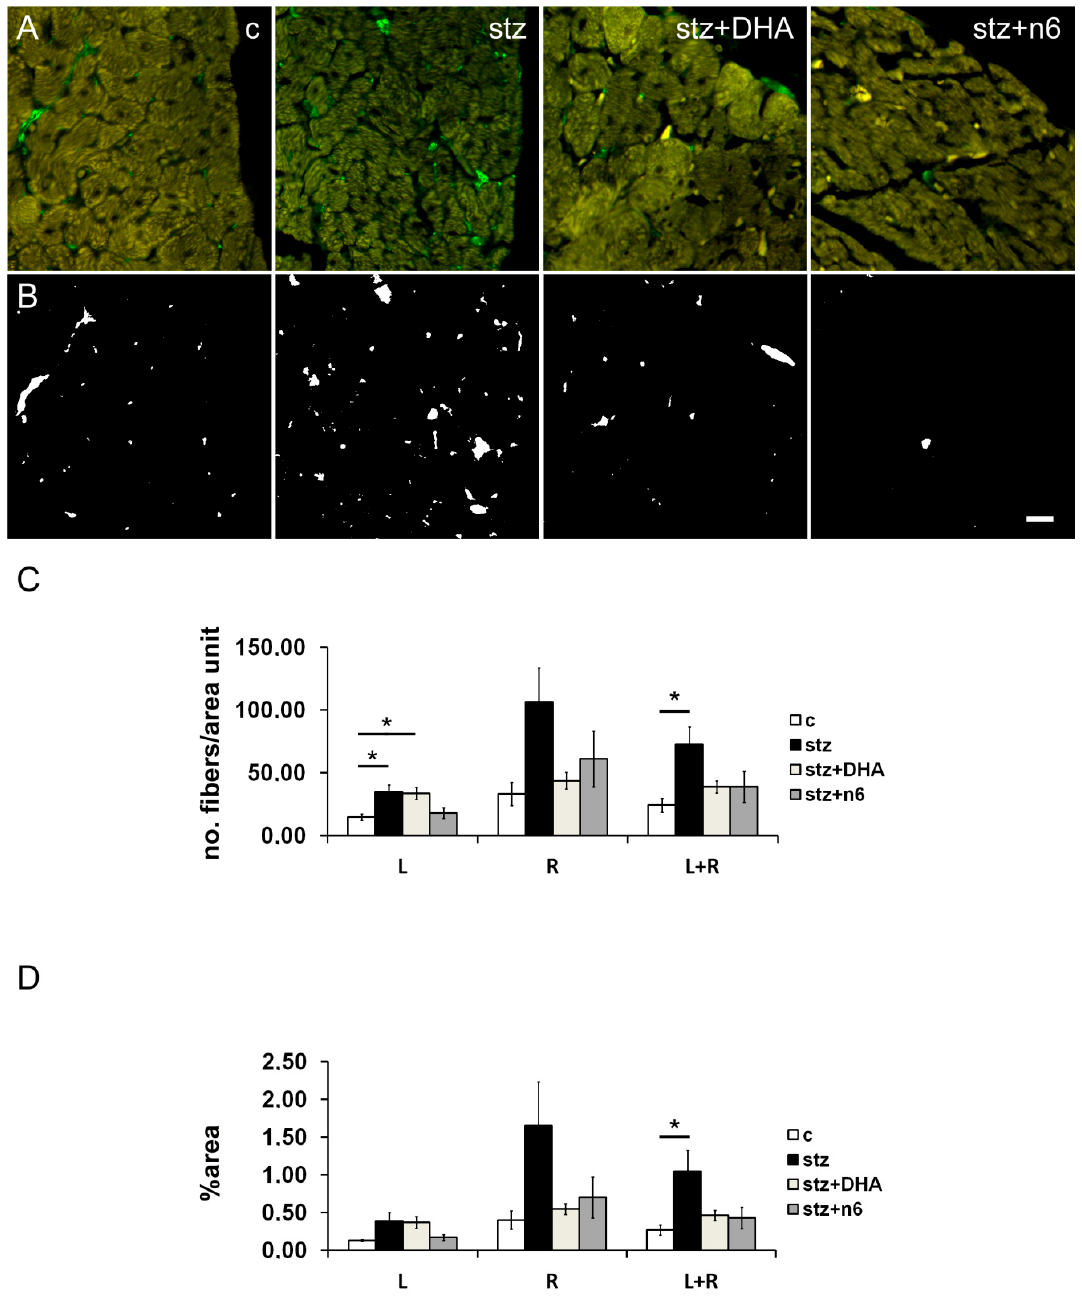
Figure 2. Protein g Product 9.5 immunoreactive nerve fiber density in subendocardial areas of cardiac septum. ( A ) Representative photomicrographs of right side of the subendocardial area of the cardiac septum stained for general neuronal marker PgP 9.5 (green). c—control group; stz—diabetic group fed standard diet (both diets n6 / n3 ratio ≈ 7); stz + DHA—diabetic group supplemented with n3 PUFA (2.5% of fish oil, containing 16% eicosapentaenoic acid—EPA and 19% docosahexaenoic acid—DHA; n6 / n3 ratio of ≈ 1); stz + n6—Diabetic group fed with diet that contained 2.5% sunflower oil (n6 / n3 ratio ≈ 60). ( B ) Threshold figures from A; white—nerve fiber area. ( C ) Neuronal density expressed as number of fibers per area unit. L—Subendocardial area facing the left ventricle; R—Subendocardial area facing right ventricle; L + R—Average from L and R. ( D ) —Neuronal density expressed as percentage of the tissue area. *— p < 0.05 di ff erence between indicated groups. Scale-bar = 20 µ